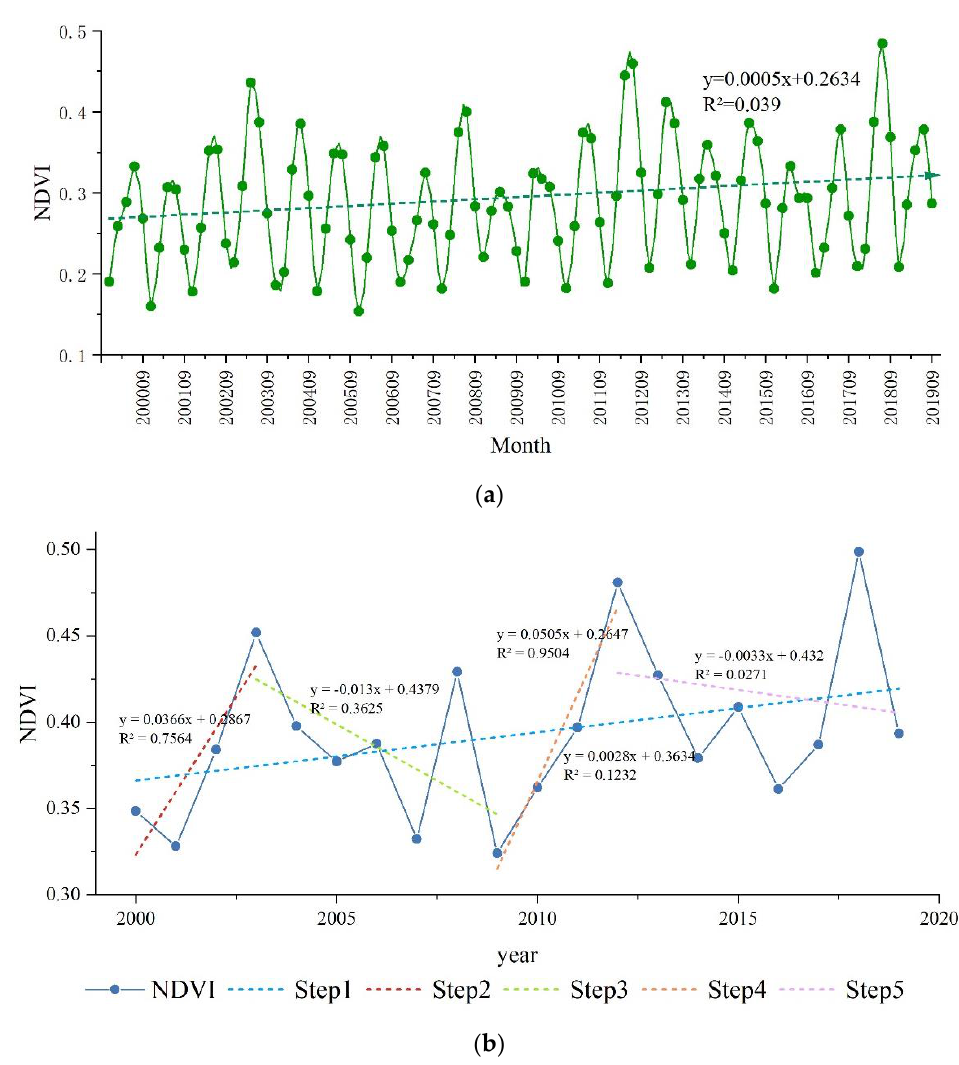
Figure 4. Temporal variation trends of NDVI in 2000–2019: ( a ) monthly variation trends in growing season and ( b ) annual variation trends.